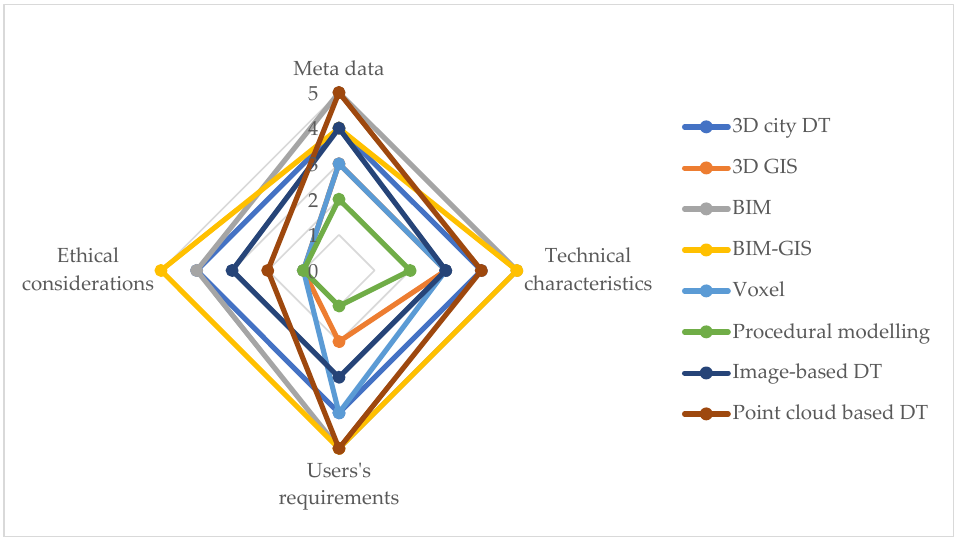
Figure 6. The spider diagrams of different 3D modelling methods. The score is calculated based on a 0–5 Likert scale for each attribute.